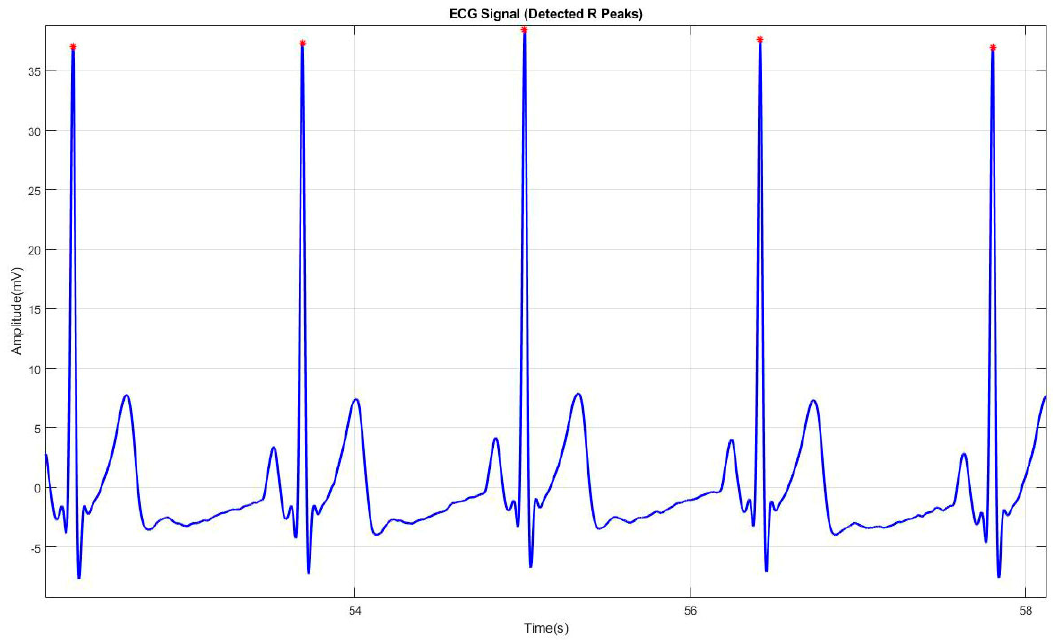
Figure 3. Representation of detected R-peaks in the ECG signal.